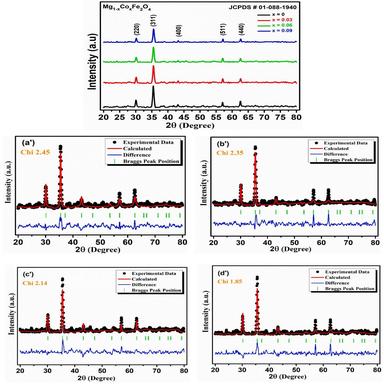
(a, a′-d′, a′′-b′′): (a) XRD patterns of Mg1-xCoxFe2O4 with (x = 0, 0.03, 0.06, and 0.09) nanoparticles, (a′- d′) Rietveld refinement of Mg1-xCoxFe2O4 with (x = 0, 0.03, 0.06, and 0.09) nanoparticles and (a′′-d′′) 3-dimensional structural imaging of pure MgFe2O4 and Mg1-xCoxFe2O4 nanoparticles.